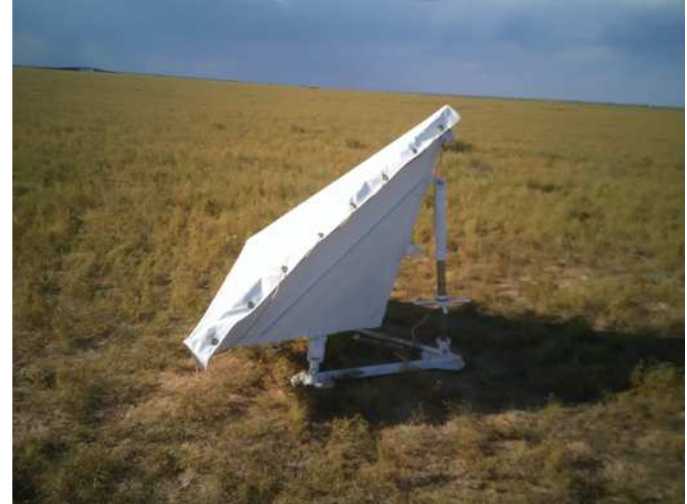
Figure 5. One of the trihedral corner reflectors (TCRs) deployed at the grassland for the GF-3